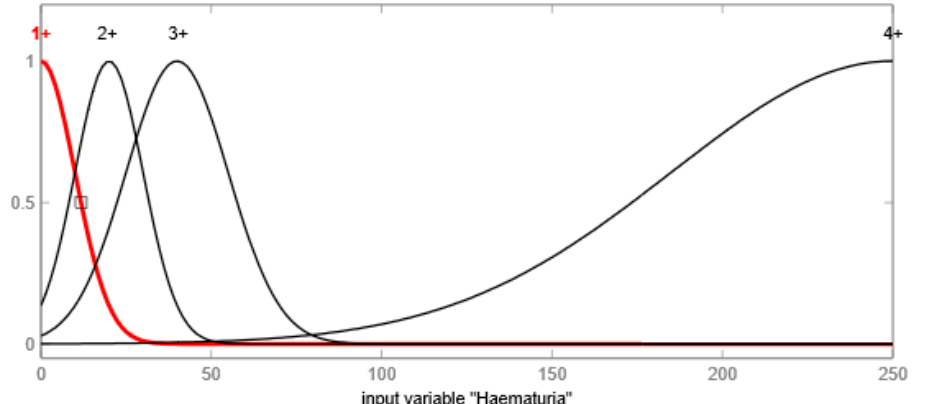
Figure 6. Membership Functions of input variable “Haematuria”.